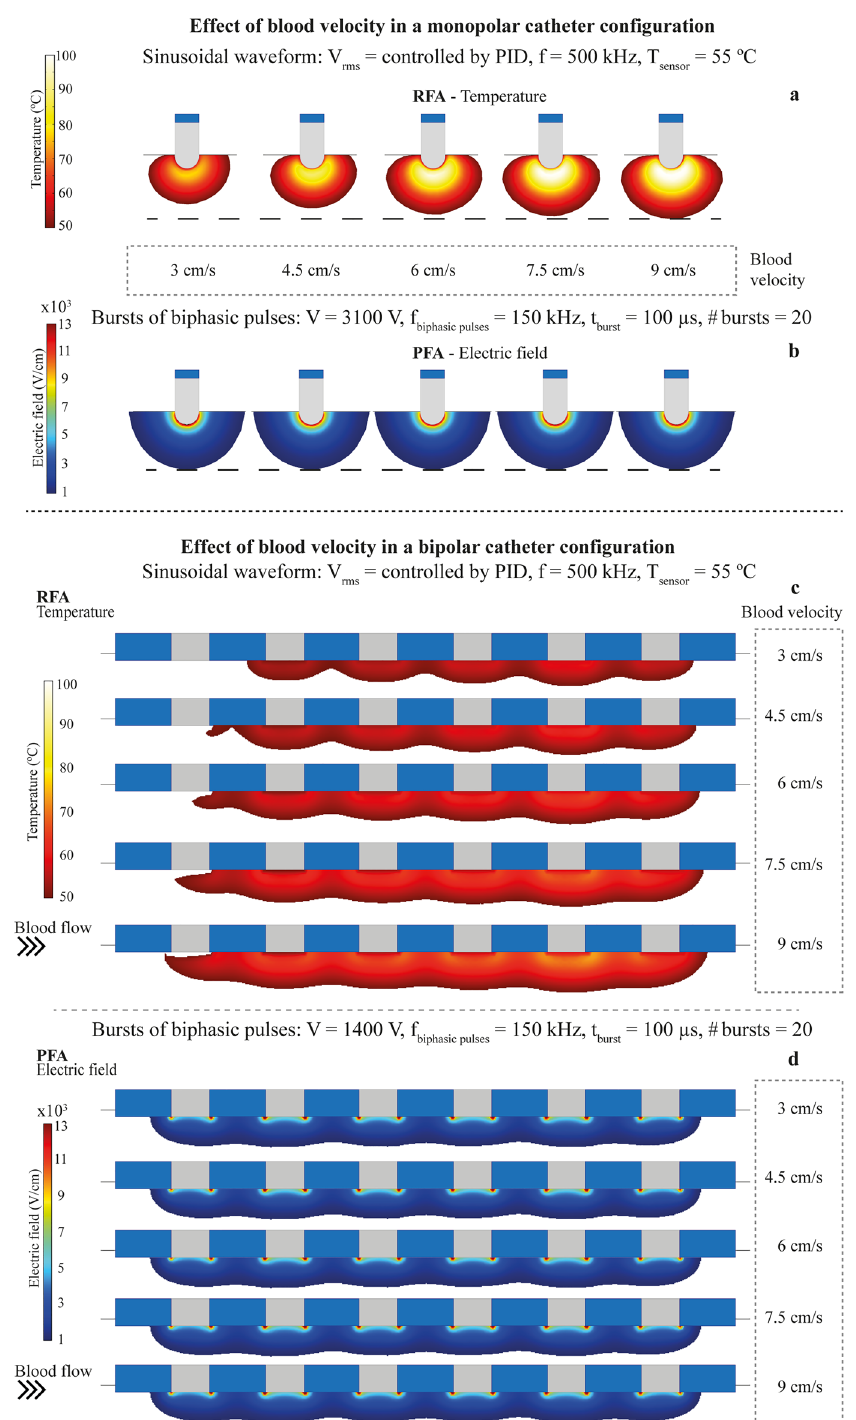
Figure 3. Lesion dependence with blood flow velocity in the monopolar catheter configuration: ( a ) simulated lesion in RFA (temperature greater than 50 ºC) and ( b ) simulated lesion in PFA (electric field magnitude greater than 1000 V/cm); and in the bipolar catheter configuration: ( c ) simulated lesion in RFA (temperature greater than 50 ºC) and ( d ) simulated lesion in PFA (electric field magnitude greater than 1000